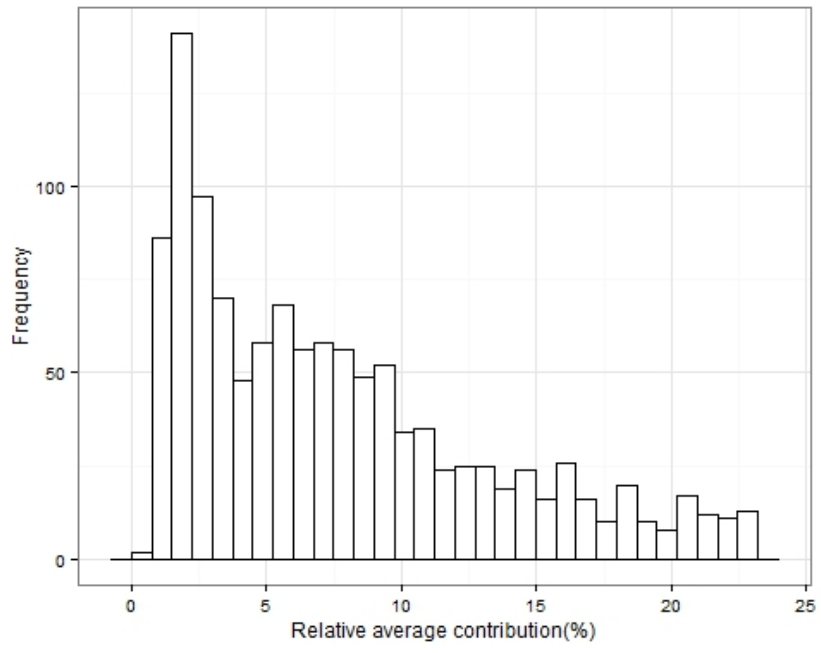
Figure 4. Distribution of the relative contribution of the constant term to the trip consumption for all